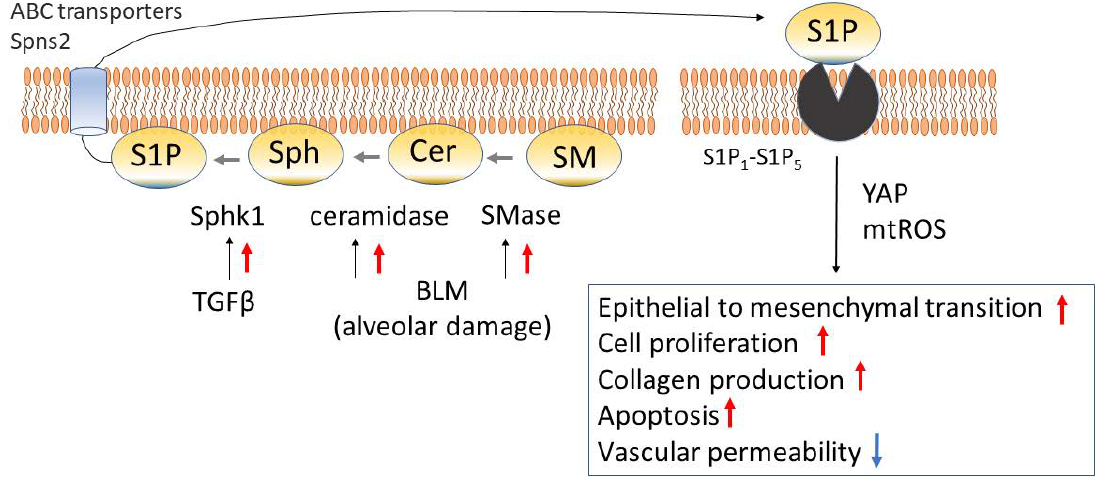
Figure 2. Sphingolipids pathway in fibrotic lung diseases. Sphingomyelin (SM) is metabolized by sphingomyelinase (SMase), yielding ceramide (Cer). It is later converted by ceramidase into sphingosine (Sph) and subsequently converted by sphingosine kinase 1 (Sphk1) into sphingosine-1- phosphate (S1P). S1P communicates with the inside and outside of cells via ATP-binding cassette (ABC) transporters and spinster homolog 2 (Spns2) and binds to S1P receptors to manifest physiolog- ical activity. Abbreviations: Bleomycin (BLM), Hippo/yes-associated protein (YAP), mitochondrial reactive oxygen species